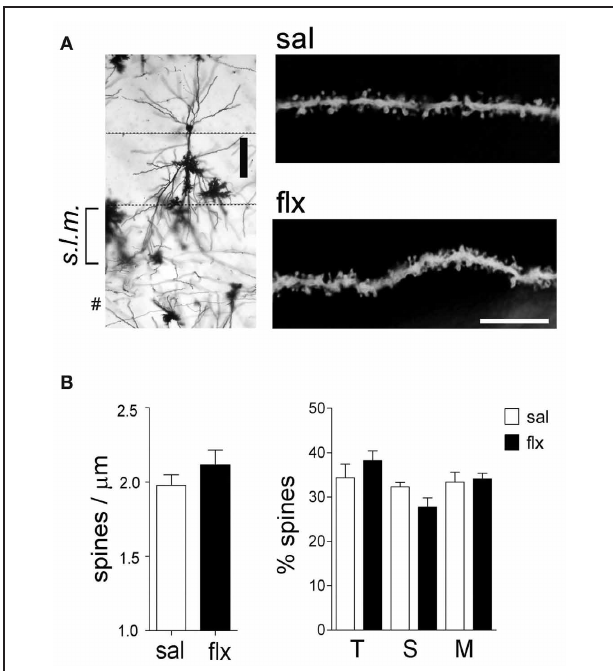
FIGURE 2 | Long-term fluoxetine treatment does not affect distal dendritic spine morphology of CA1 pyramidal neurons. (A) Left: Golgi stained CA1 pyramidal neuron indicating the stratum lacunosum moleculare ( s.l.m.) where the morphological analysis was performed. # At this level can be observed granule neuron dendrites coming from dentate gyrus. Scale bar: 100 μ m. Right: representative dendritic segments of saline and fluoxetine-treated rats under larger amplification. Scale bar: 10 μ m. (B) The number of spines and the morphology of spines were analyzed and plotted as spine density and % of spine type, respectively. Filopodia/thin (T), stubby (S), and mushroom/branched (M) shape categories are shown. Results are presented as mean ± SEM and were determined from 10 to 11 cells per condition, obtained from five saline (total spines, 979)- and six fluoxetine (total spines, 942)-treated rats. Data were not statistically significant after a Mann–Whitney U -test